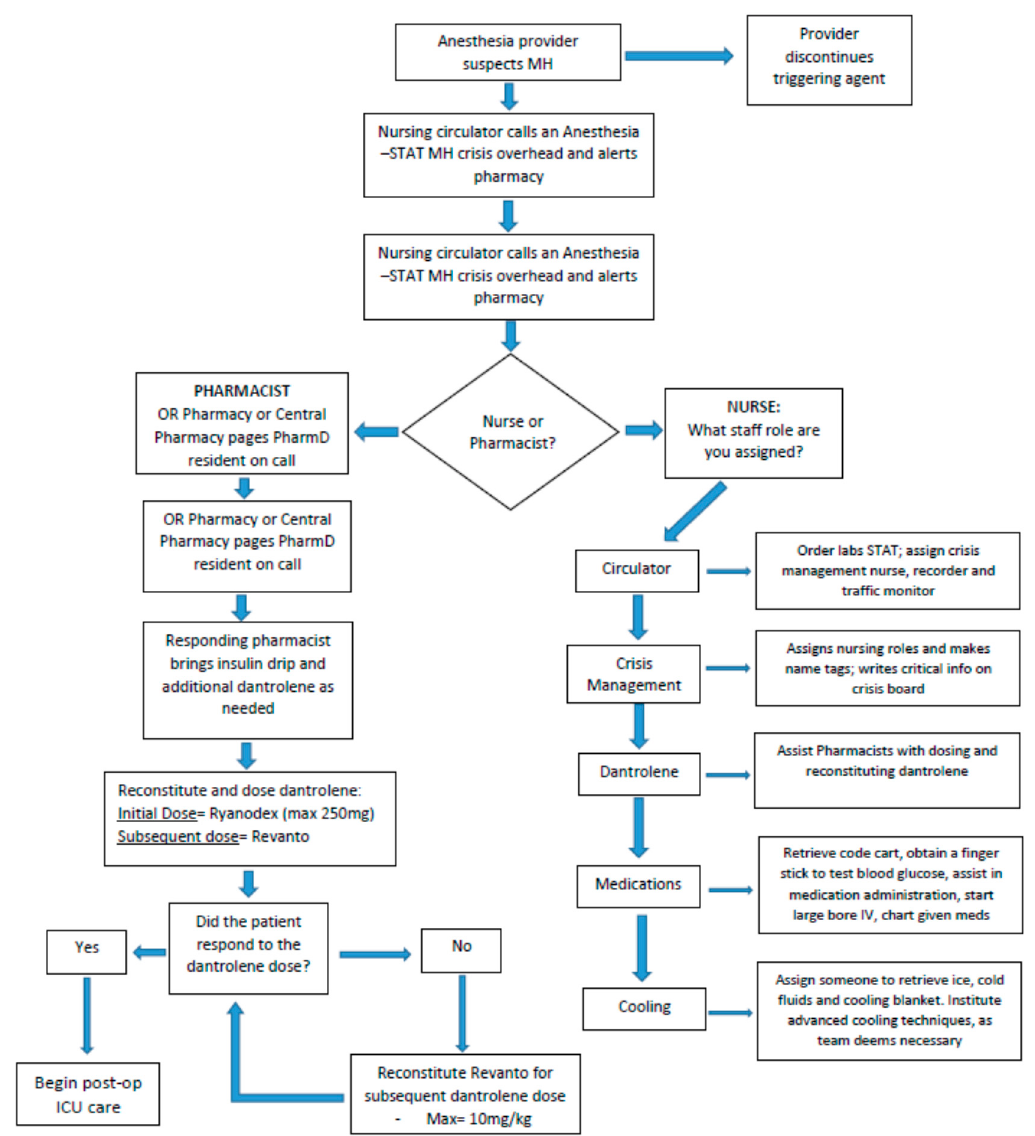
Figure 1. Sequence of events involved in Malignant Hyperthermia Response. Table 1. Contents of Malignant Hyperthermia Cart.